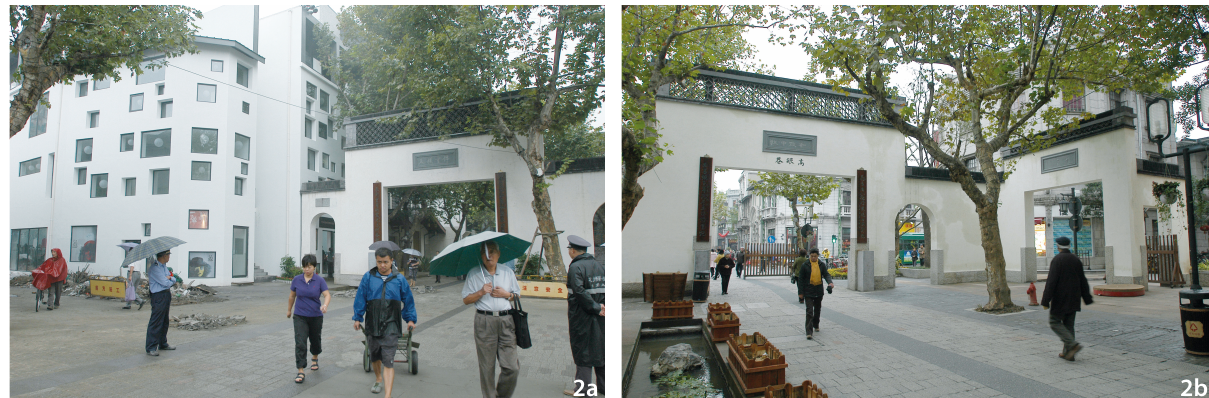
Figure 2 Intervention on the block wall and the street (Source: the